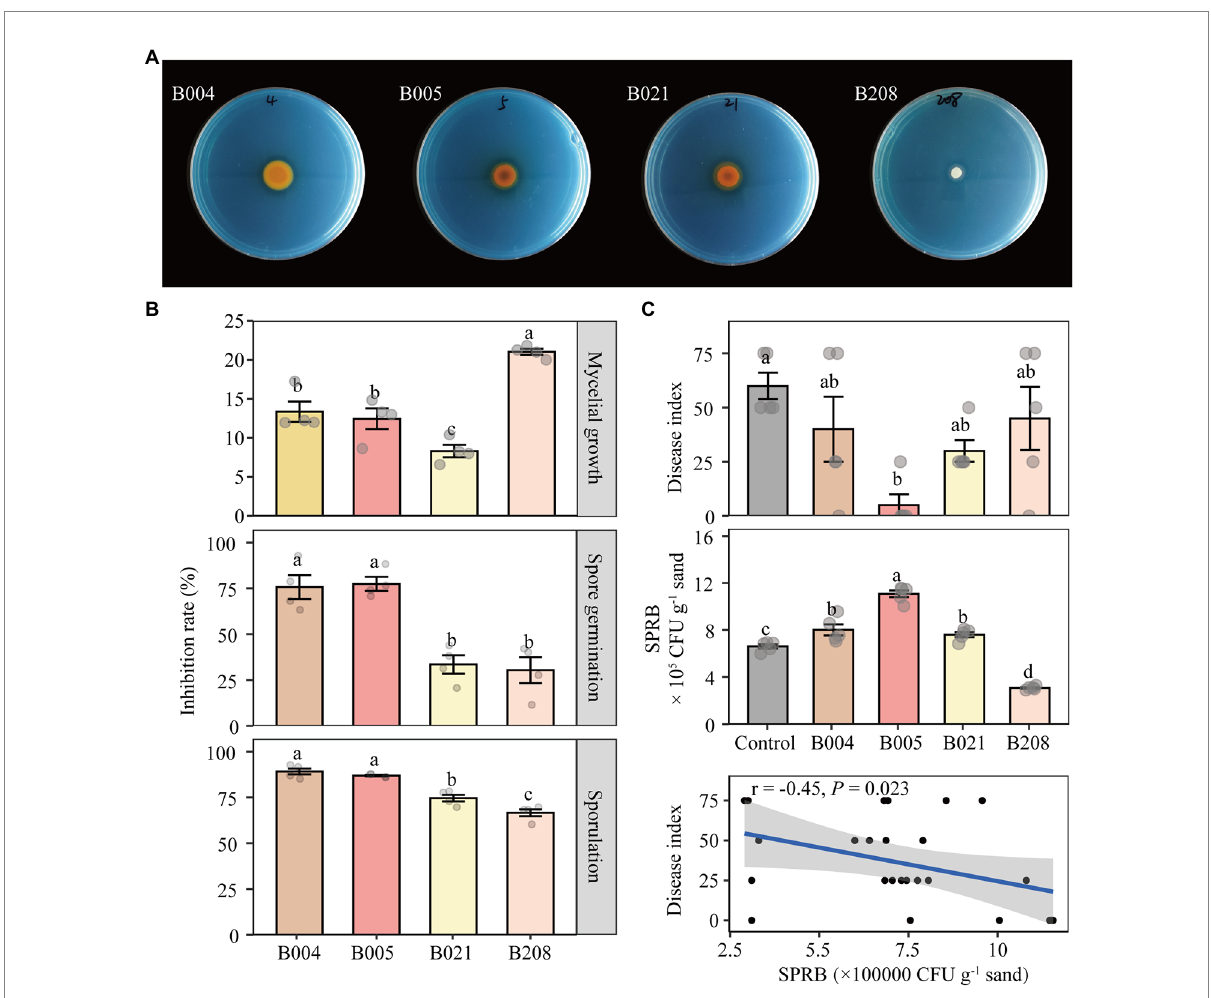
FIGURE 6 Siderophore-producing capability of the four antagonistic isolates (A) . Effect of metabolites of the four isolates on mycelial growth, spore germination and sporulation of FOF (B) . Disease index of Fusarium wilt and the number of siderophore-producing rhizobacteria (SPRB) in the control (sterilized water) and inoculated treatments B004, B005, B021 and B208, and the correlation of the two indicators (C) . B004 and B021 are affiliated with Pseudomonas chlororaphis ; B005 with Bacillus megaterium and B208 with Bacillus subtilis . Different lowercase letters in each plot indicate significant differences according to Duncan’s multiple range test at p <